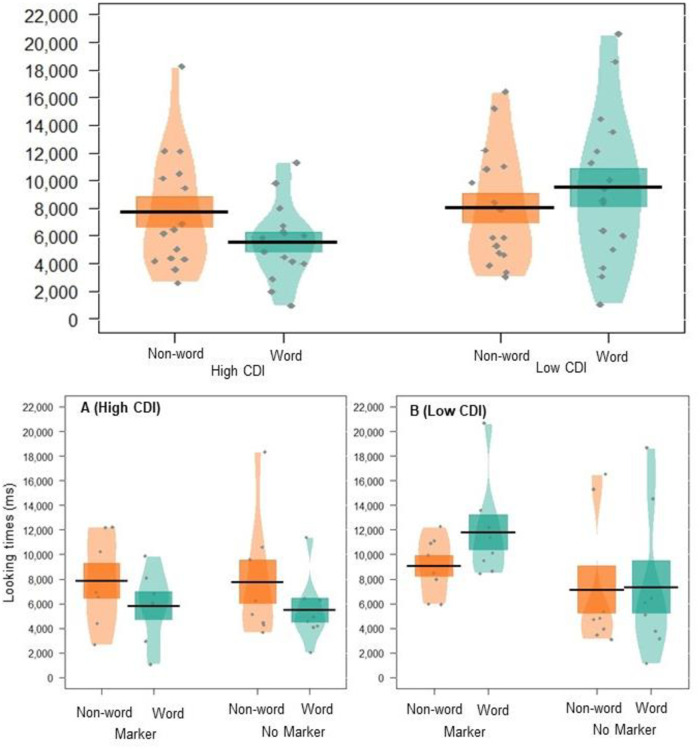
Pirate plot depicting the (raw) mean looking times to words and non-words for the participants in experiment 1.The top panel displays this data for High and Low CDI groups. The bottom panel breaks this down into each markers condition, with the High CDI group in panel A and the Low CDI group in panel B. Black lines indicate the mean, and coloured blocks indicates SE. Coloured shapes show the distribution of looking times for each group, with individual data points in grey.